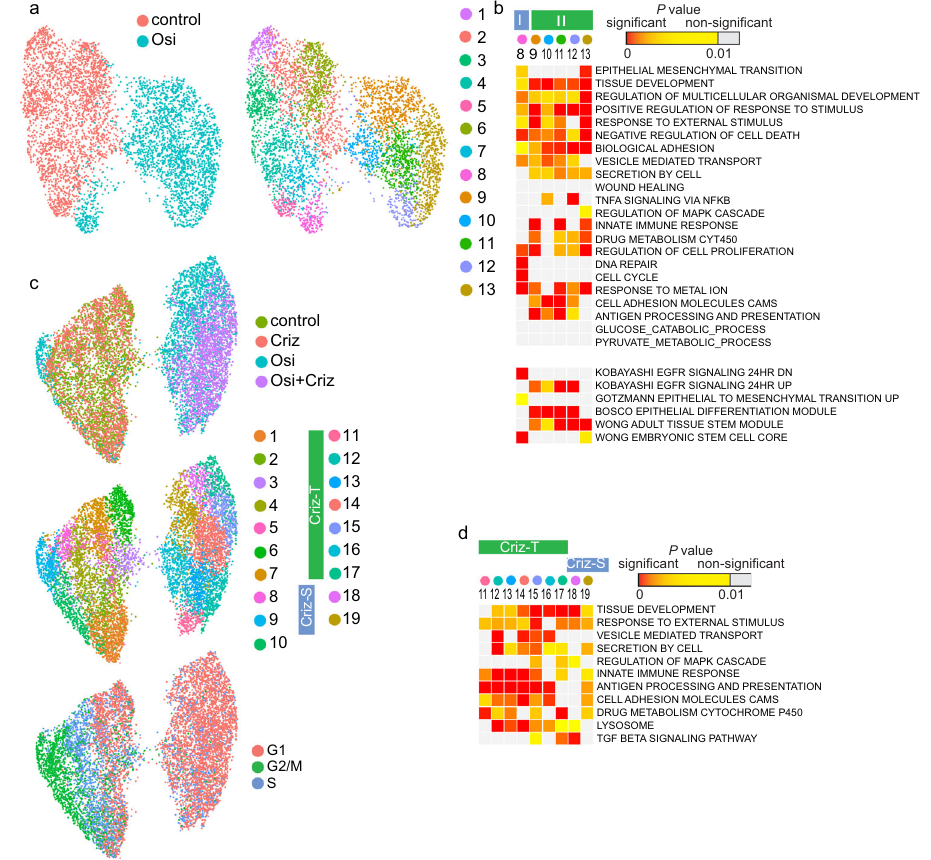
Fig. 7 Crizotinib inhibits the emergence of a de fi ned subset of osimertinib-tolerant cell populations in vivo. a UMAP representation of tumor cells from mice treated with osimertinib for 3 days and control mice treated with vehicle, colored by clusters (on the right). b Enrichment analysis for top cluster markers ( P < 0.05). Data are presented for the terms in Fig. 4c and any additional gene set with P < 3×10 − 6 in most of the clusters of either osimertinib- treated or control tumors. Two subpopulations of tolerant cells, I and II, are delineated by blue and green boxes. c UMAP representation of tumor cells from mice treated with the combination of crizotinib and osimertinib, each drug alone and vehicle control. All mice were treated for 3 days. Treatment replicates are colored by the drug (at the top), by clusters (in the middle), and the cell cycle phase positioning of each cell (at the bottom). d Enrichment analysis for markers of DT clusters, which are either crizotinib-tolerant (Criz-T) or crizotinib-sensitive (Criz-S). Data is presented for the terms in Fig. 6c and any additional gene set with at least 10 − 6 difference in P value in majority of the Criz-T clusters from Criz-S clusters and control tumors. In b and d , data represents right tail P values, two-sided binomial statistical test, adjusted for multiple testing using Benjamini – Hochberg FDR method; gene relations to GO BP terms, KEGG pathways and hallmark gene sets (MSigDB collections) are shown for top markers ( P <